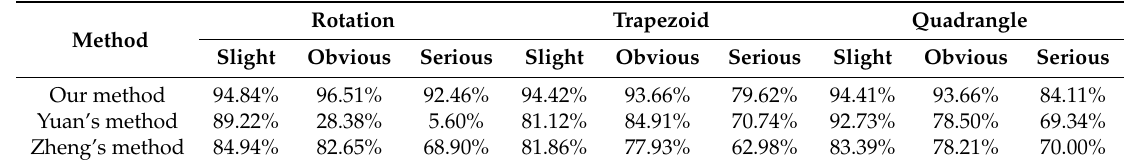
Table 2. Accuracy of various perspective transformation.